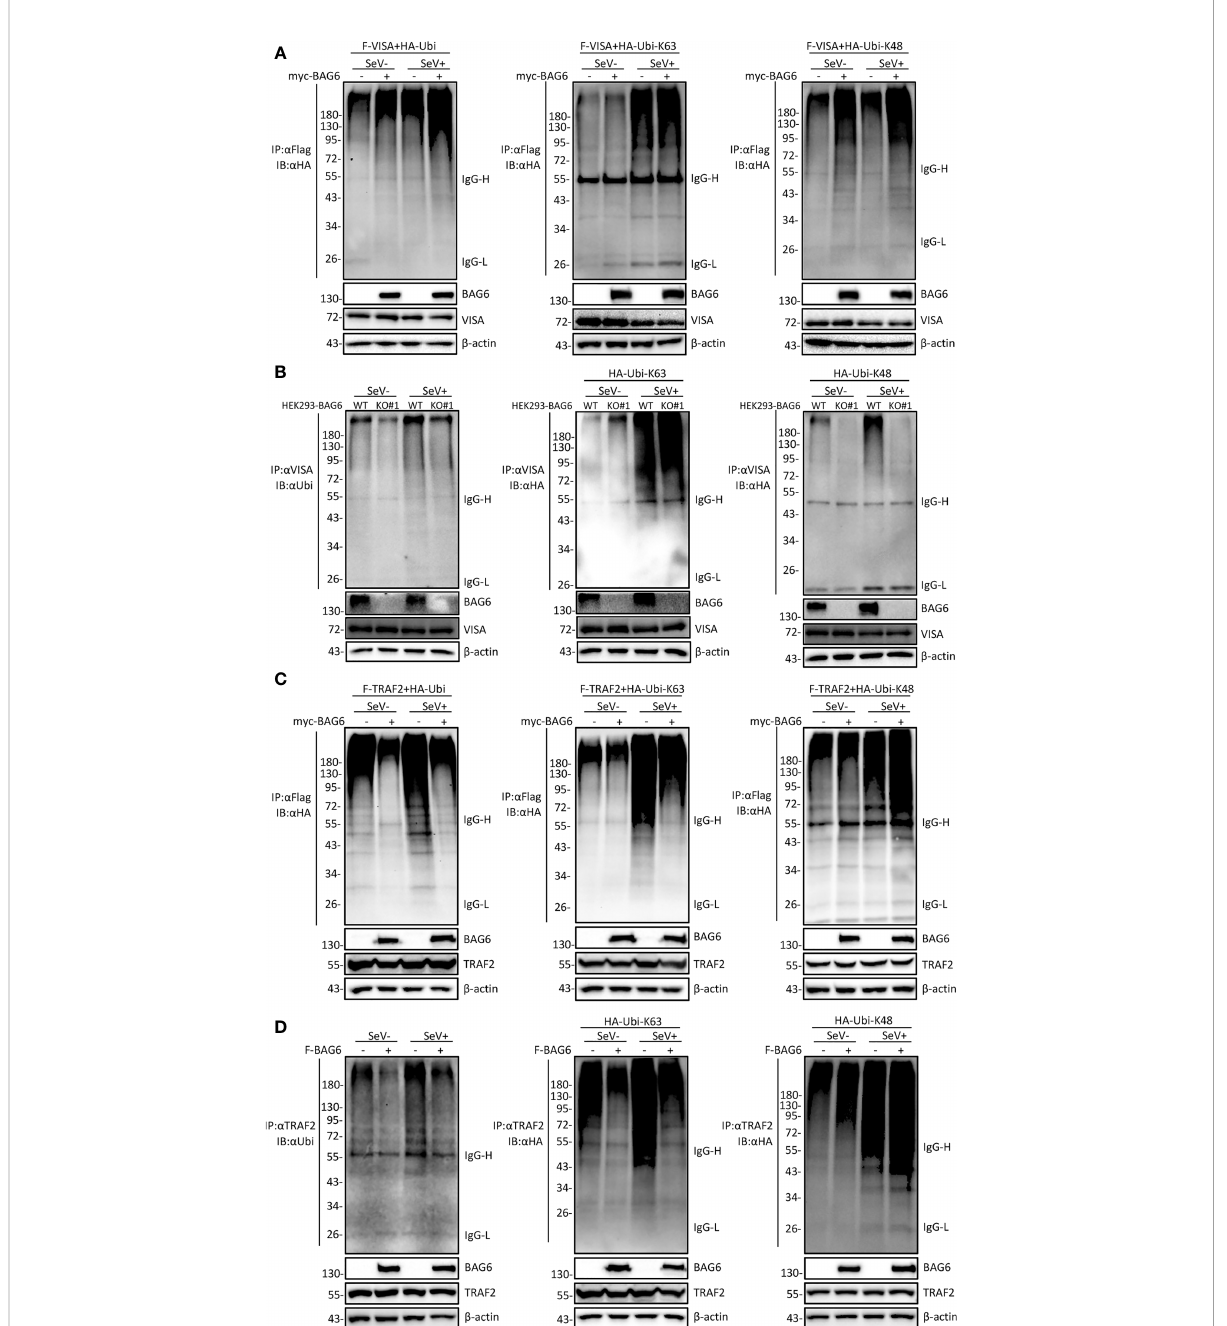
FIGURE 6 BAG6 promotes the K48-linked ubiquitination of VISA/TRAF2. (A) Overexpression of BAG6 increases the K48-linked polyubiquitin of VISA. HEK 293 cells (4×10 6 ) were transfected with Flag-VISA, HA-ubiquitin (WT, K63R, or K48R), and Myc-BAG6 plasmids for 22 h, and cells were untreated or treated with SeV (MOI = 1) for 10 h before co-immunoprecipitation and Western bolting analysis. (B) BAG6-de fi ciency inhibits the K48-linked polyubiquitin of VISA. HEK 293 wild type and BAG6-de fi cient cells (4×10 6 ) were transfected with HA-ubiquitin (K63R or K48R) for 22 h, and cells were untreated or treated with SeV (MOI = 1) for 10 h before co-immunoprecipitation and Western bolting analysis. (C) Overexpression of BAG6 increases the K48-linked polyubiquitin and impairs the K63-linked polyubiquitin of TRAF2. HEK 293 cells (4×10 6 ) were transfected with Flag- TRAF2, HA-ubiquitin (WT, K63R, or K48R), and Myc-BAG6 plasmids for 22 h. Cells were untreated or treated with SeV (MOI = 1) for 10 h before co-immunoprecipitation and Western bolting analysis. (D) Overexpression of BAG6 increases the K48-linked polyubiquitin and impairs the K63- linked polyubiquitin of endogenous TRAF2. HEK 293 cells (4×10 6 ) were transfected with HA-ubiquitin (WT, K63R, or K48R) and Flag-BAG6 plasmids for 22 h, and cells were untreated or treated with SeV (MOI = 1) for 10 h before co-immunoprecipitation and Western bolting